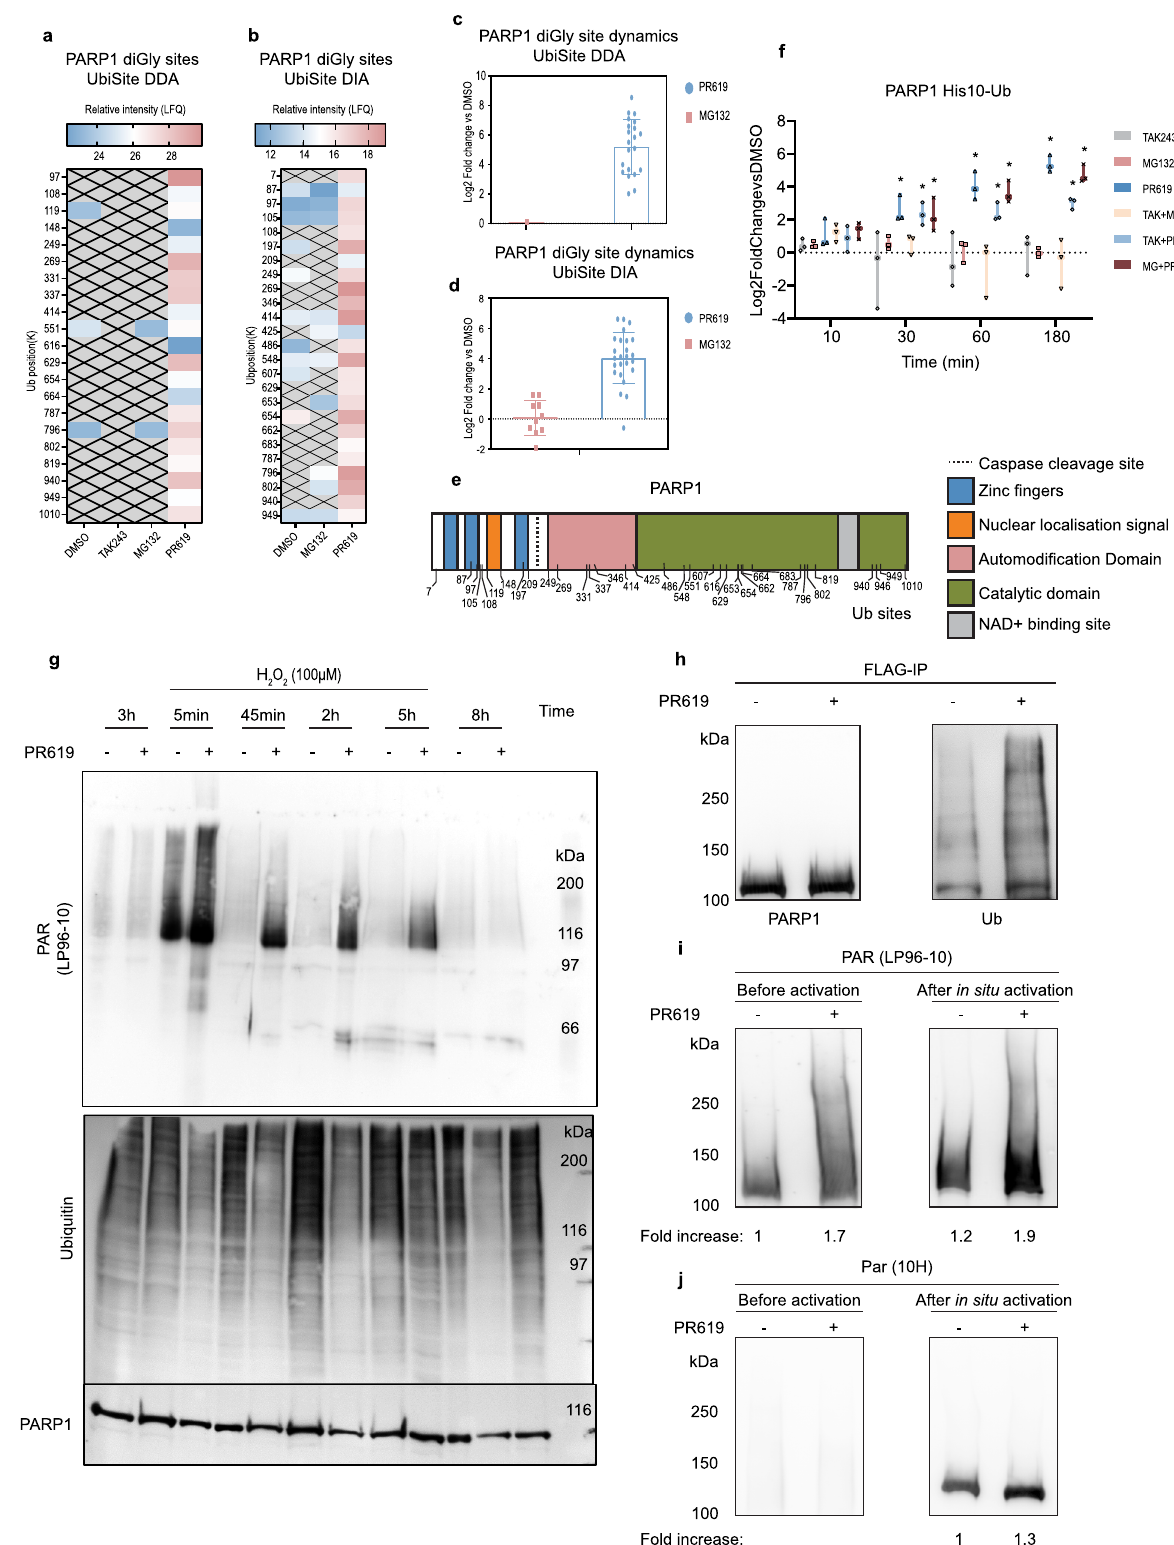
cells (Fig. 7i, right panel). Notably, the 10H probing of these blots revealed a negligible PAR signal in both the samples under endogenous conditions prior to PARP1 activation, and a strong signal for PAR in the position of PARP1 in both samples with a modestly improved capacity of PARP1 to form large PAR in PR619-treated cells (Fig.